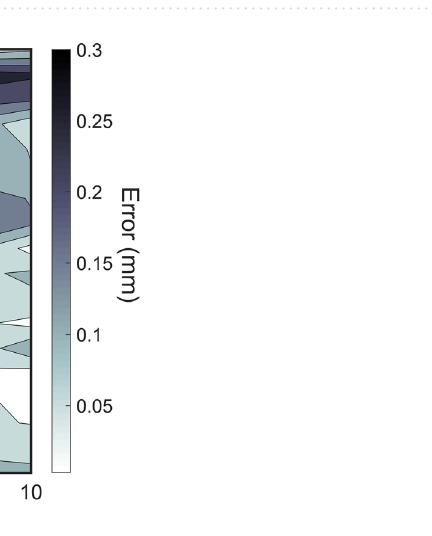
Figure 3. Displacement errors in all tested configurations for the N45 grade magnets as a function of θ. The 10% threshold (red solid line) corresponds to 10% the MM 5 trajectory length (i.e. 1 mm) and the right angle. For θ ≥ 31° (threshold identified by the red dashed line), errors (95th percentile) proved generally below the 10% threshold, and showed a negative correlation with the sensing area (numbers in italics indicate the ρ s value for each θ). Such correlation was lost for θ < 31°, where errors proved always above the 10% threshold. Both position (first row) and orientation (second row) errors are shown.